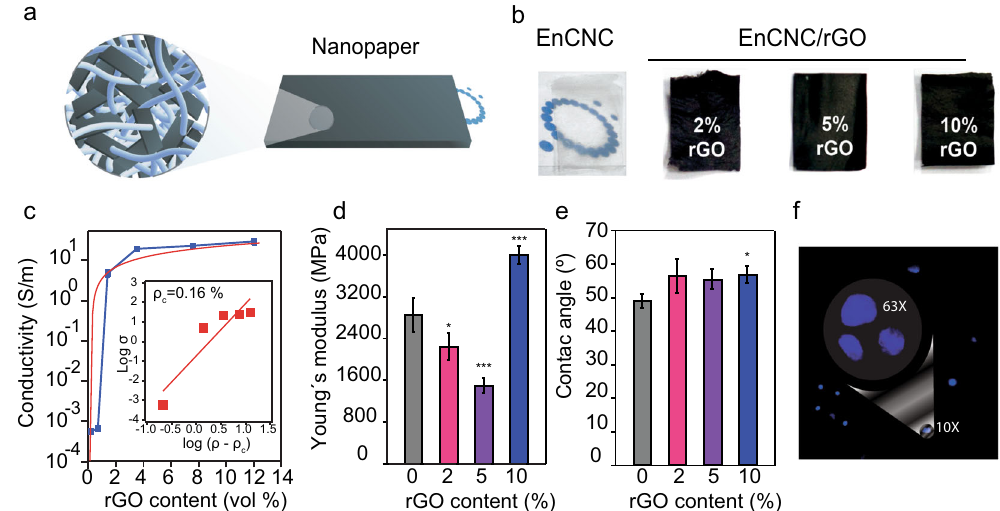
Fig. 5 EnCNC/rGO nanopapers characterization. a Illustration of hybrid nanopaper, the conductive nanopapers were produced by mixing graphene oxide (GO) with nanocellulose and its posterior reduction once the paper was assembled. b Photographs of fi lms prepared with EnCNC and EnCNC with different reduced graphene content: 2, 5, and 10 wt% rGO addition produced a black appearance to the fi lms. c Conductive of EnCNC fi lms at different rGO content (volumetric %), inset shows a log – log plot for determination of electrical percolation threshold of the ( ρ c ). d Young ’ s modulus of the EnCNC fi lm and EnCNC fi lms with different rGO concentrations. e Water contact angle measurement for neat EnCNC and nanocomposites with different rGO content. The average values and S.D. were calculated from fi ve independent experiments (* P < 0.05; ** P < 0.01; *** P < 0.001; **** P < 0.0001). f Confocal microscopy image at ×10 and zoom at ×63 of adhered HEK293T dyed with DAPI in a substrate made of 10 wt% EnCNC suspension with 10% rGO. Cells proliferate in the composite substrate after 3 days.